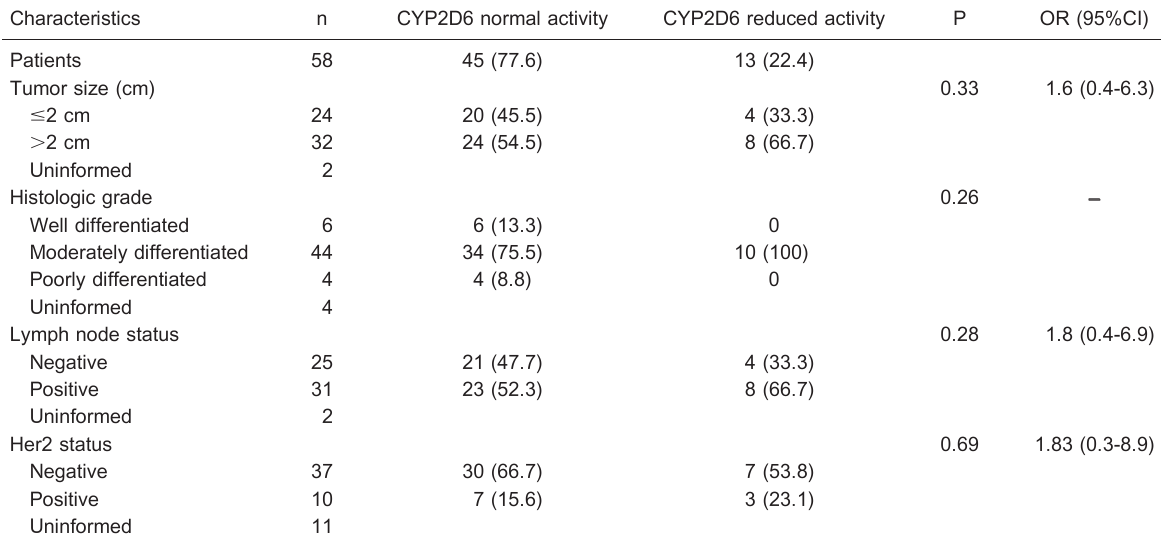
Table 4. Association between the CYP2D6 *10 genotype and patient characteristics.